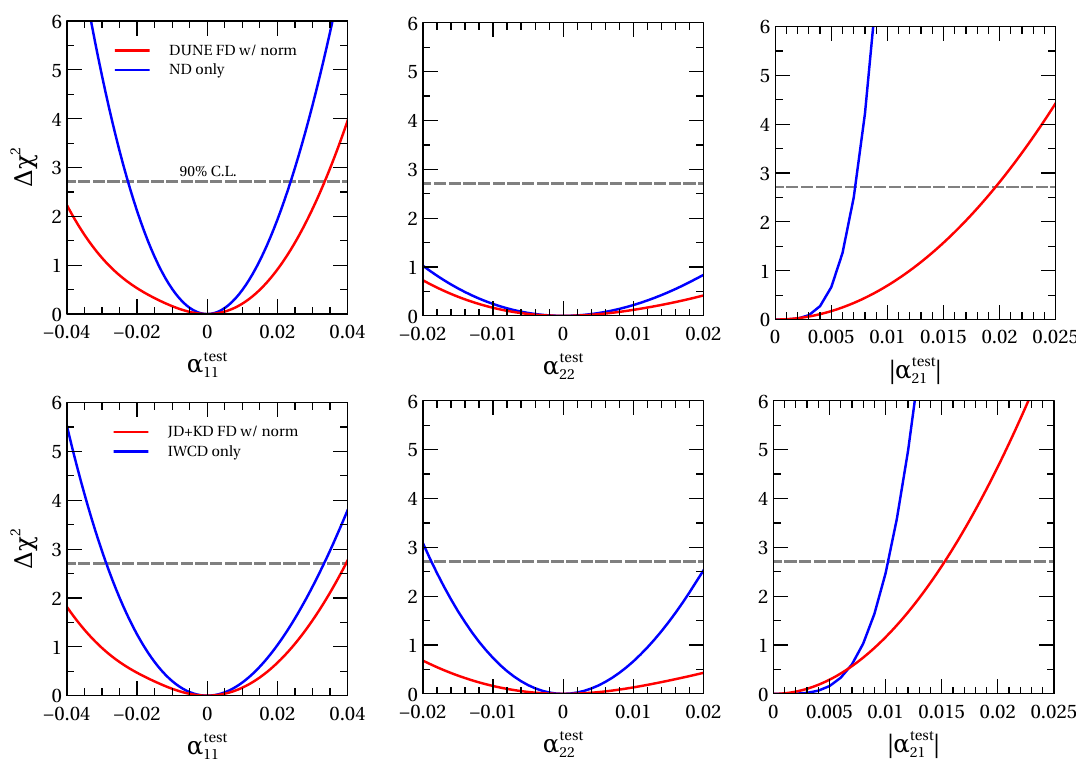
Figure 7 . Upper panels show the improvements in the sensitivities to α 11 , α 22 , and | α 21 | due to the presence of 67 tons LArTPC near detector placed at distance of 574 meters from the neutrino source for DUNE. Lower panels portray the same for JD+KD having a 1 kt water Cherenkov near detector placed at a distance of 1 km from J-PARC. The blue curves show the performance with only near detectors. The red curves represent the combined sensitivities due to both near and far detectors. True values of the standard oscillation parameters are taken from table 2. We obtain our results marginalizing over δ in the range [ − 180 ◦ , 180 ◦ ] and θ in the range [40 ◦ , 50 ◦ ] in the fit. CP 23 We also marginalize over the associated phase φ in the range [ − 180 ◦ , 180 ◦ ] for the off-diagonal 21 NUNM parameter | α 21 |